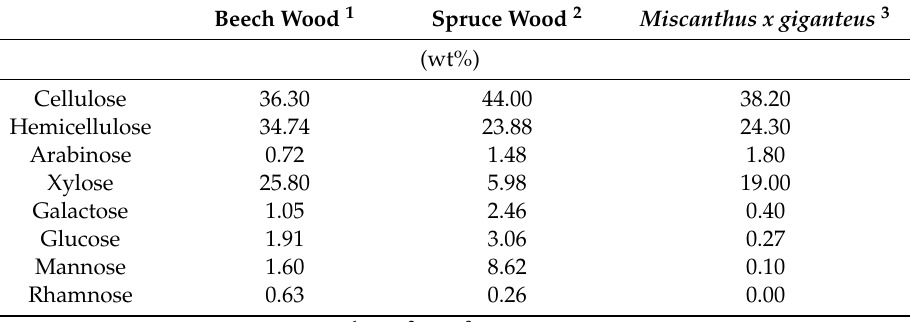
Table 1. Comparison of the cell composition of beech and spruce wood, and Miscanthus x giganteus . Beech Wood 1 Spruce Wood